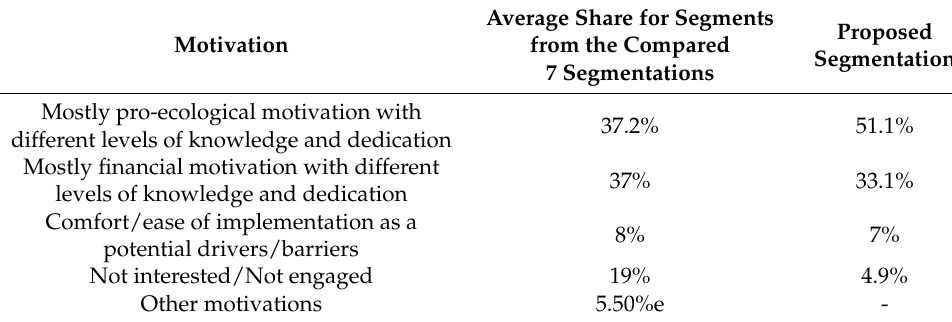
Table 9. Comparison of the shares of respondents in particular